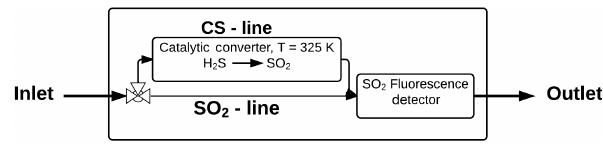
Figure 1. Schematic of the 450 Hydrogen Sulfide–Sulfur Dioxide